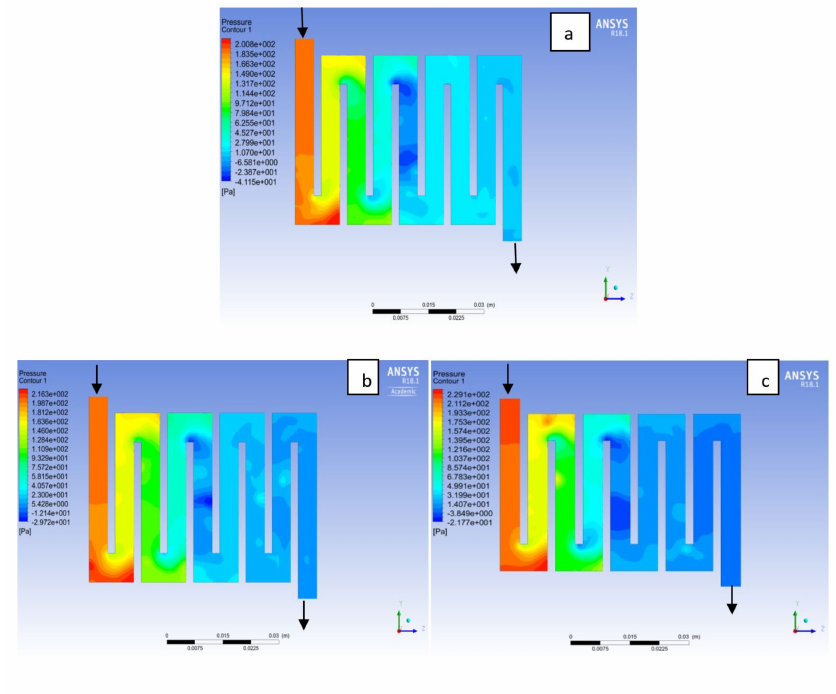
Figure 12. Pressure distribution at the anode region (GDL/CL) for each material with temperature